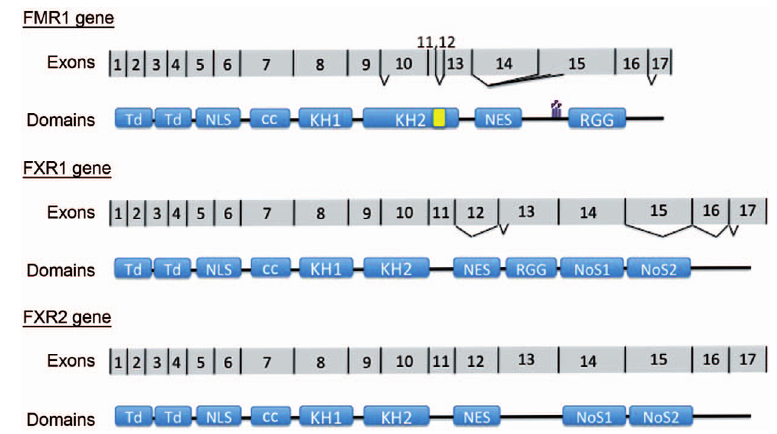
Figure 1 Gene structures and corresponding protein domains of the fragile X family members. Exons are numbered 1–17 and reported splice site usage is indicated by lines below the exons (9–11). Exons 1–10 of all three proteins encode for similar domain structures. Since FXR1 and FXR2 do not have sequence equivalent to exons 11 and 12 of FMR1, the numbering diverges: in FXR1 and FXR2, the NES is encoded by exon 12; the RGG box in FXR1 is encoded by exon 13 and the nucleolar